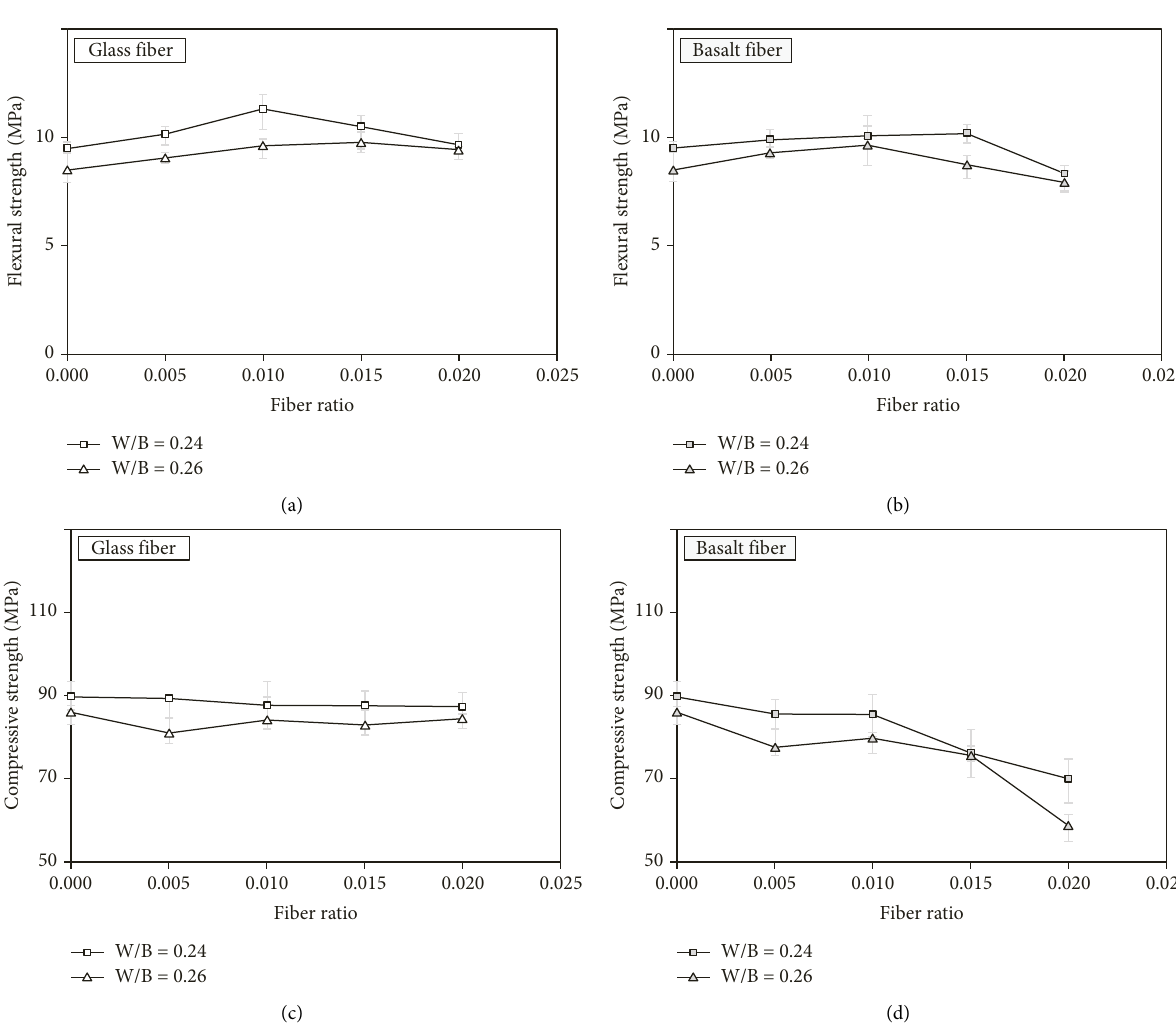
Figure 24: Flexural strength (a)(b) and compressive strength (c)(d) of printed components due to changes in fiber ratio